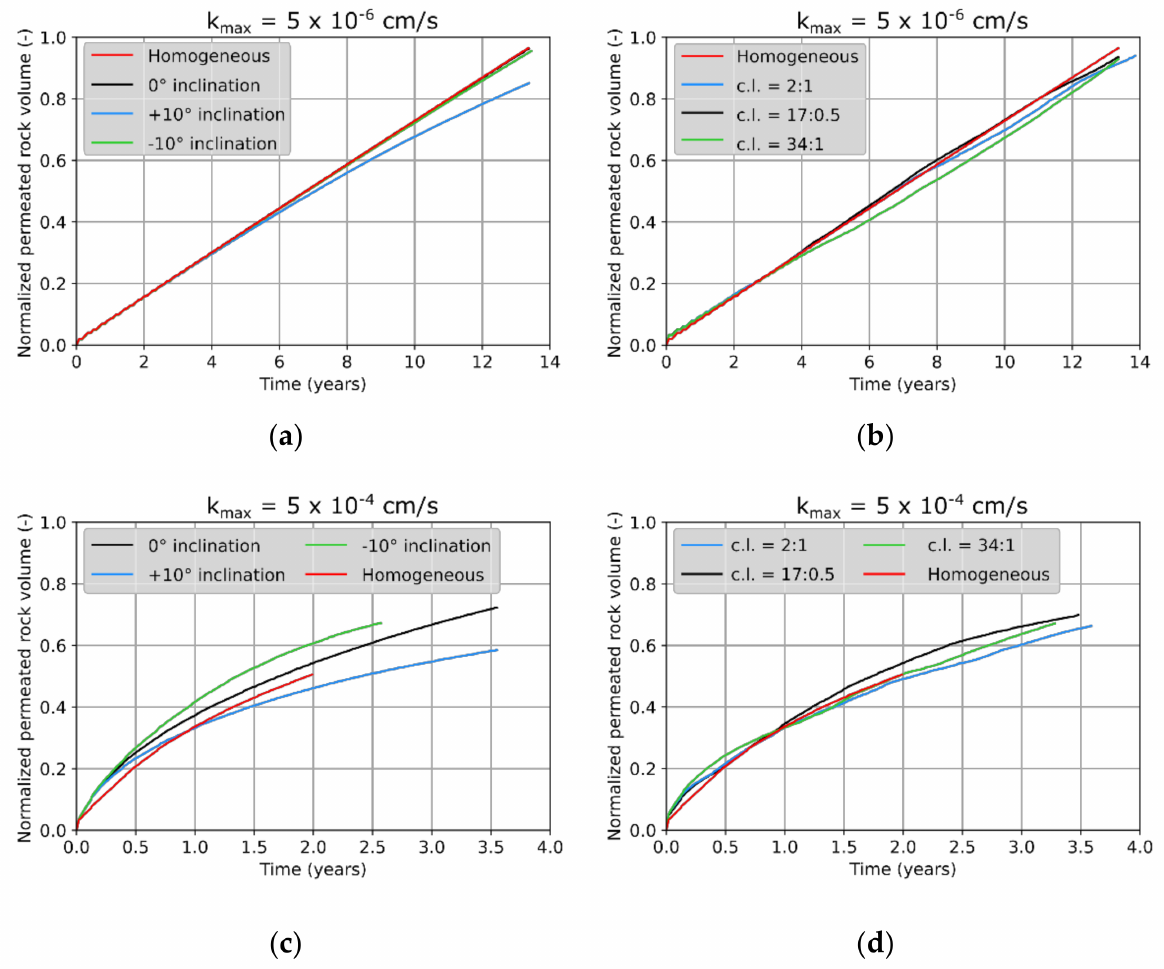
Figure 7. Ratio between permeated and total (soluble) rock volume over time for ( a , c ) an intersecting halite layer and ( b , d ) halite inclusions (c.l., correlation length) compared to the homogeneous